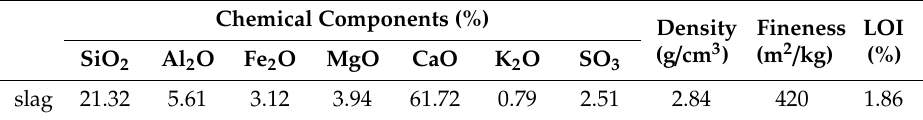
Table 1. Properties of